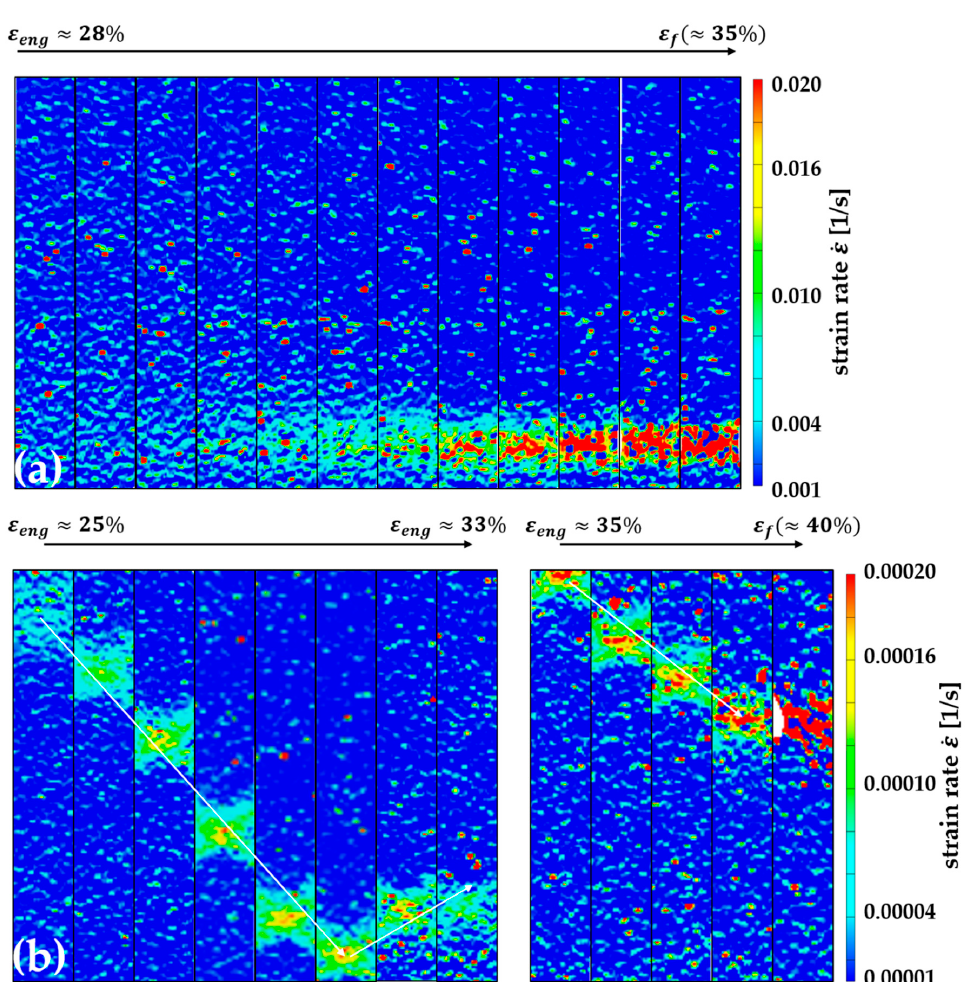
Figure 11. Visualization of the local strain rate distribution in a tensile test sample prior to necking initiation using in-situ DIC during tensile testing at ( a ) 0.001 1/s and ( b ) 0.00001 1/s. White arrows highlight the propagation of localized peaks in strain rate during straining.